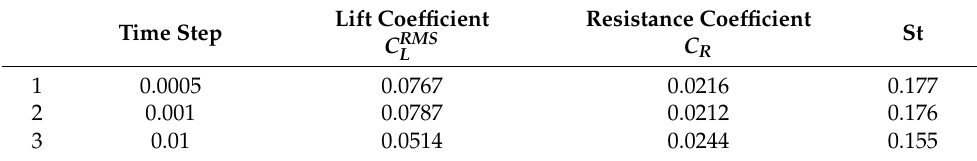
Table 3. Comparison of simulation results on time step (the number of grids: